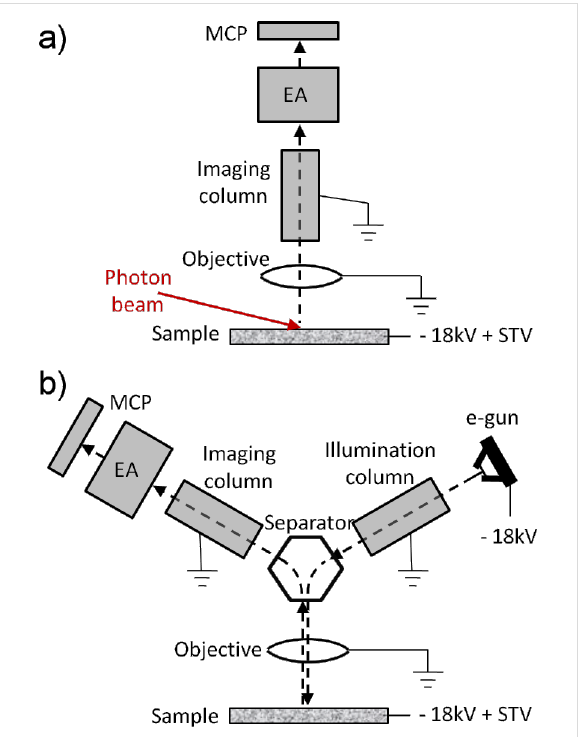
Figure 1: The simplified schematic description of a) XPEEM, b) LEEM. The energy analyzer (EA) is optional in both cases. Panel (b) with the energy analyzer represents also the SPELEEM